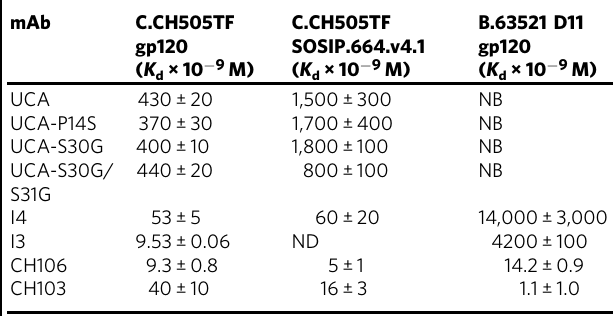
Table 1 Effect of heavy chain mutations on thermostability in the CH103 lineage